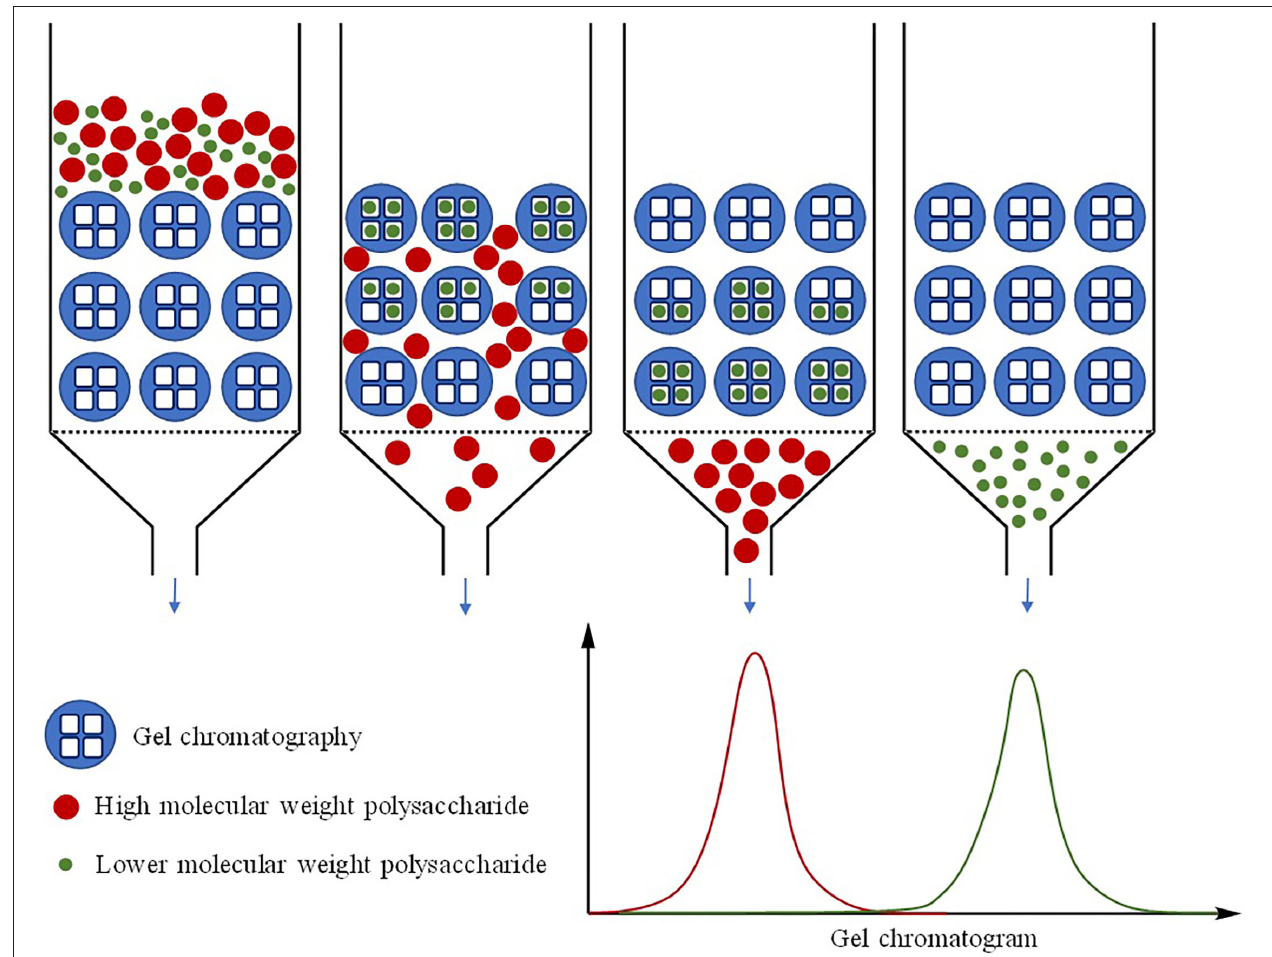
FIGURE 2 | The schematic diagram of mechanism for determination of molecular weight of CHPs by